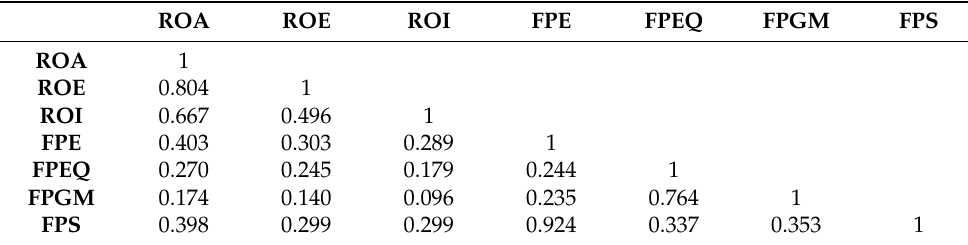
Table 7. The correlation matrix for gas companies.